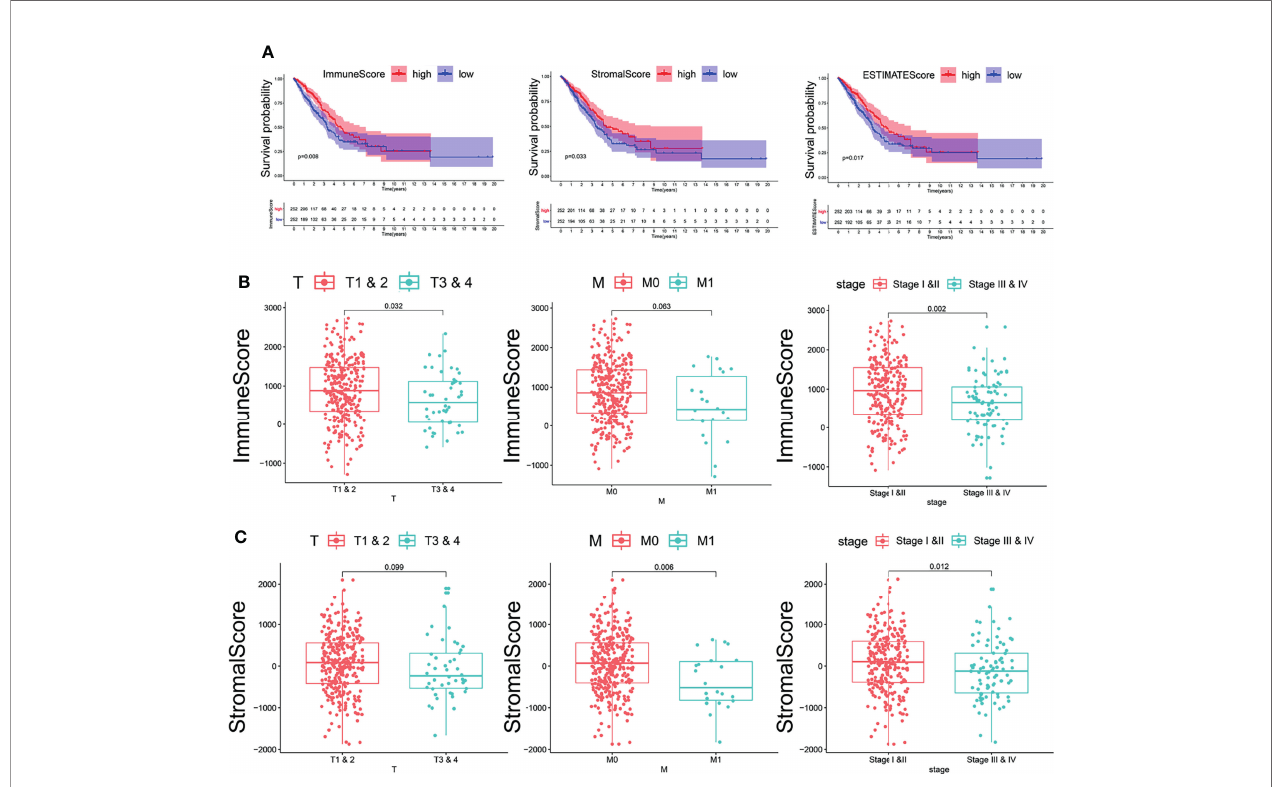
FIGURE 1 | The relationship between immune and stromal scores and clinical features and prognosis of lung adenocarcinoma. (A) The relationship between immune and stromal scores and prognosis of lung adenocarcinoma. The red line represents the high-scoring group, and the blue line represents the low-scoring group. (B) The correlation between immune scores and clinicopathological features. (C) The correlation between stromal scores and clinicopathological